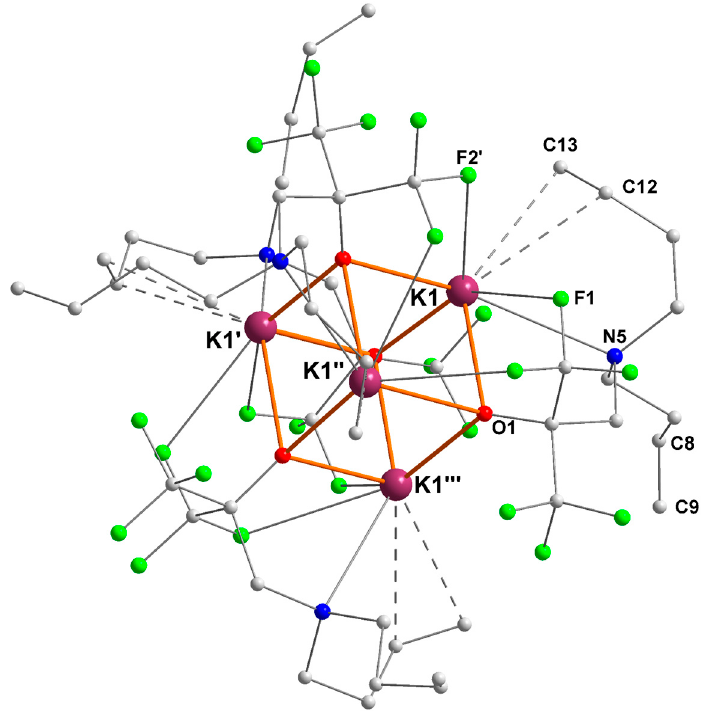
Figure 4. Representation of the molecular solid-state structure of the potassium–alkene complex [{RO 3 }K] 4 ([ 3 ] 4 ). Color code: purple, K; green, F; blue, N; red, O; grey, C. H atoms omitted for clarity.